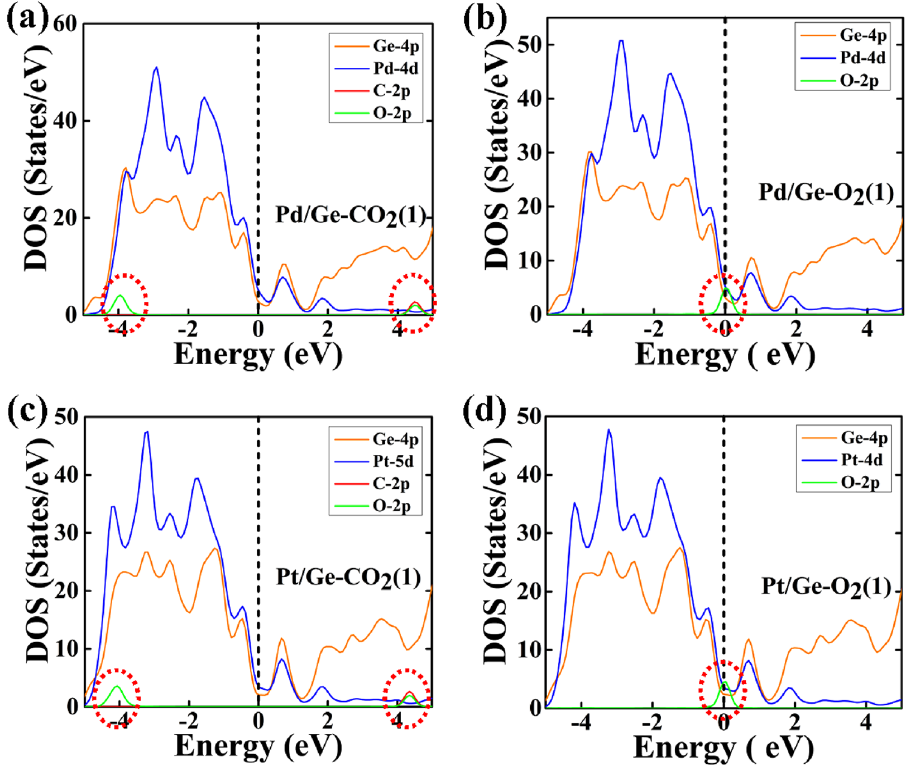
Figure 8. The partial density of states (PDOS) of type 1 geometry of CO 2 and O 2 , are adsorbed on Pd/Ge and Pt/Ge core–shell NW: ( a ) CO 2 adsorbed Pd/Ge NW, ( b ) O 2 adsorbed Pd/Ge NW, ( c ) CO 2 adsorbed Pt/Ge NW and ( d ) O 2 adsorbed Pt/Ge NW. The Fermi energy is set at 0